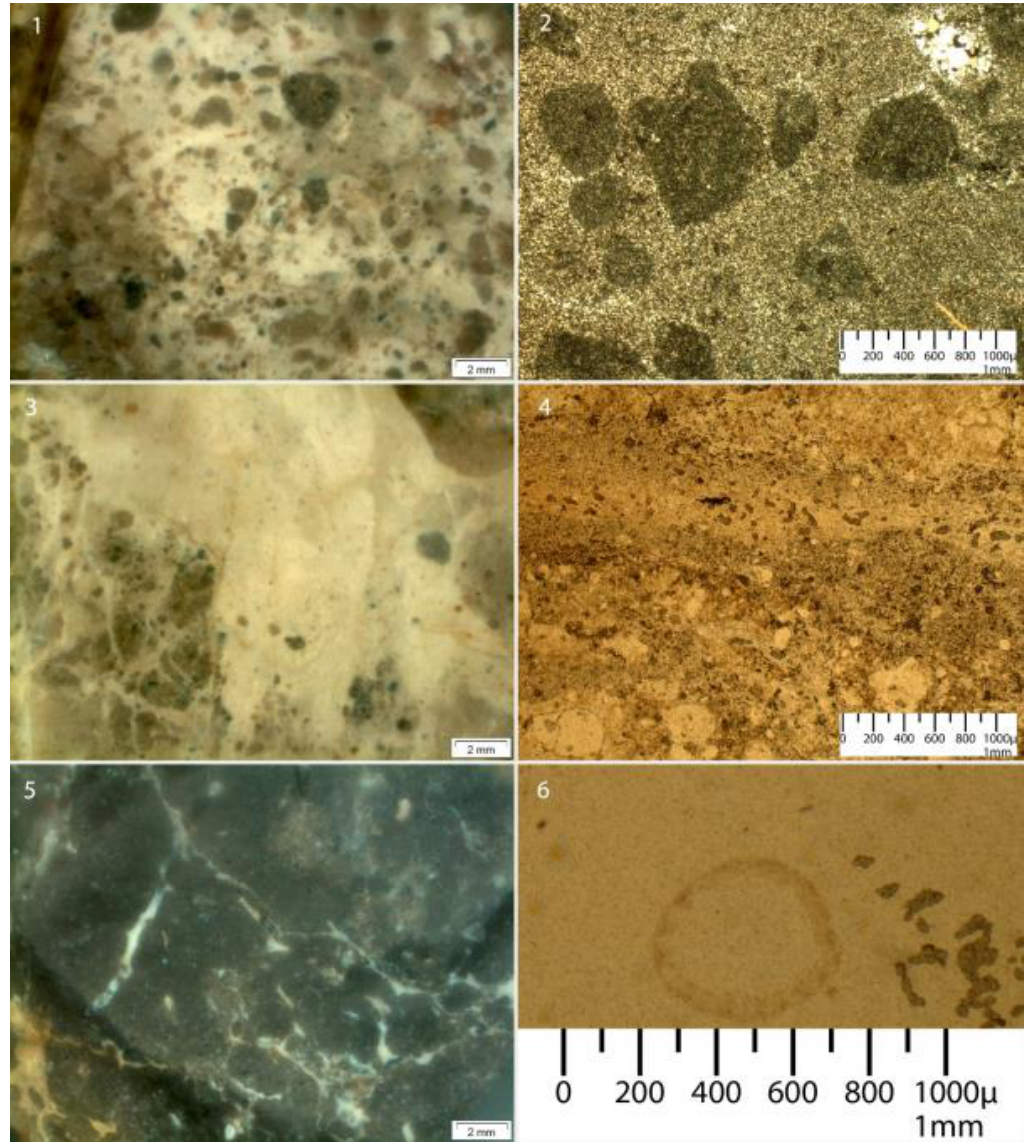
Figure 5. Oxfordian flints’ macro and microscopic textures and constituents; Genetic Type J3-3: 1., 3., 5. General heterogenic textures (mudstone to grainstone) (scale bar = 2 mm); 2. Brecciated sedimentary structure (scale bar = 1 mm); 4 Laminated sedimentary structure (scale bar = 1 mm); 5. Charophyta stem (scale bar = 1 mm).